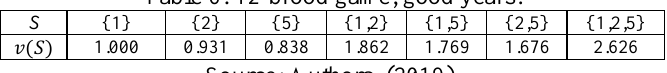
Table 6: 12-brood game, good years.